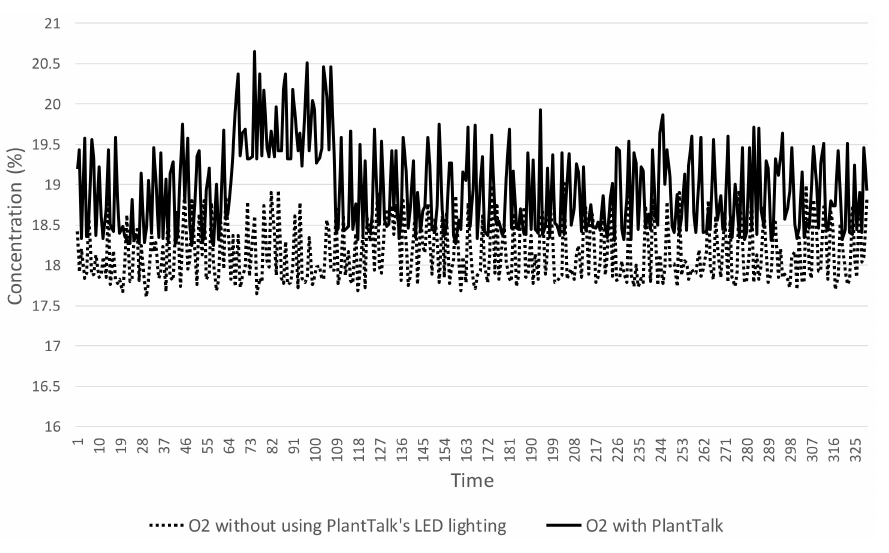
Figure 8. CO 2 reduction experiment.